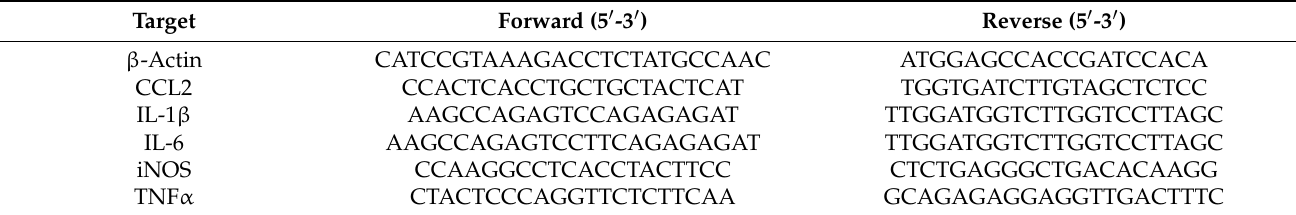
Table 2. Sequences of primers for real-time